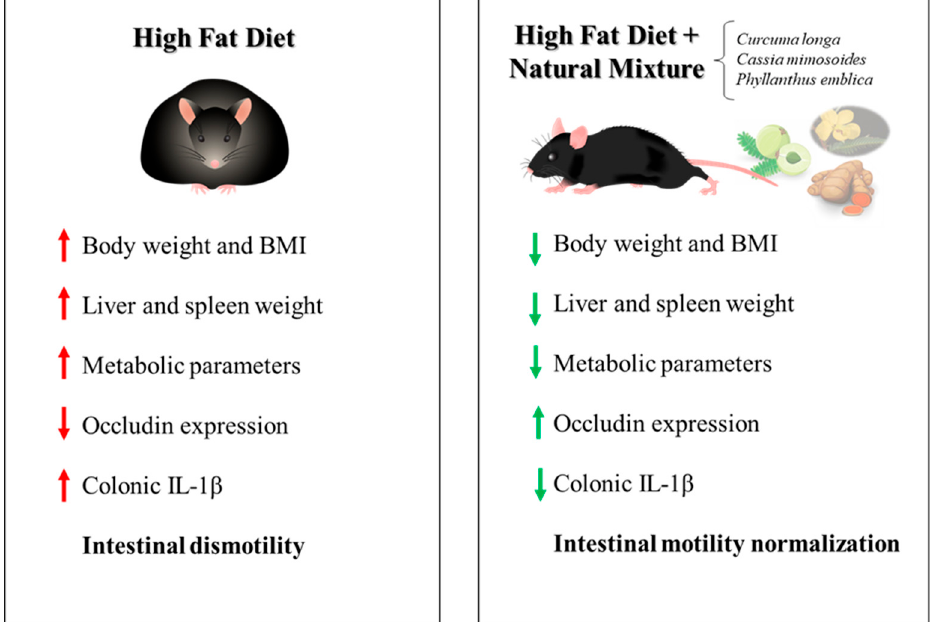
Figure 6. Schematic representation of the anti-obesity properties of dietary supplement, containing the dry extract of Curcumin , Emblica and Cassia , in a murine model of HFD diet.